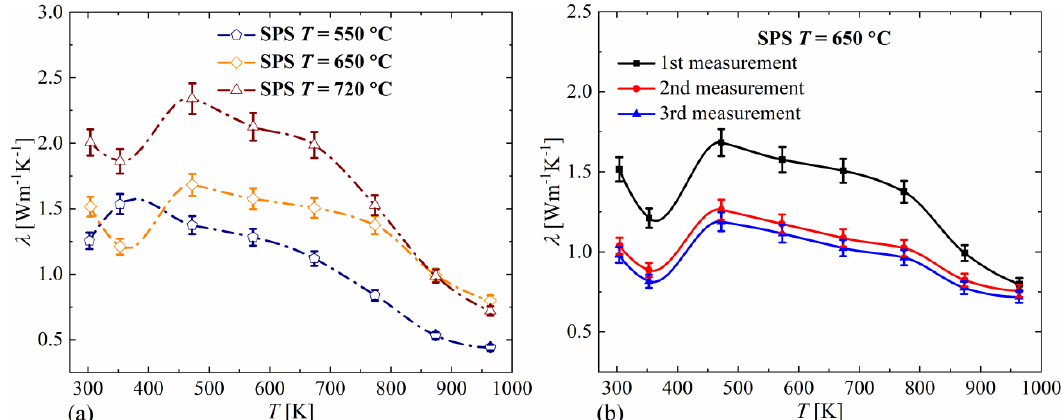
Figure 6. Thermal conductivity for Cu 2 Se samples sintered at different temperatures ( a ) and for different measuring cycles for the sample sintered at 650 °C ( b ) (absolute errors for α r = 0.05).